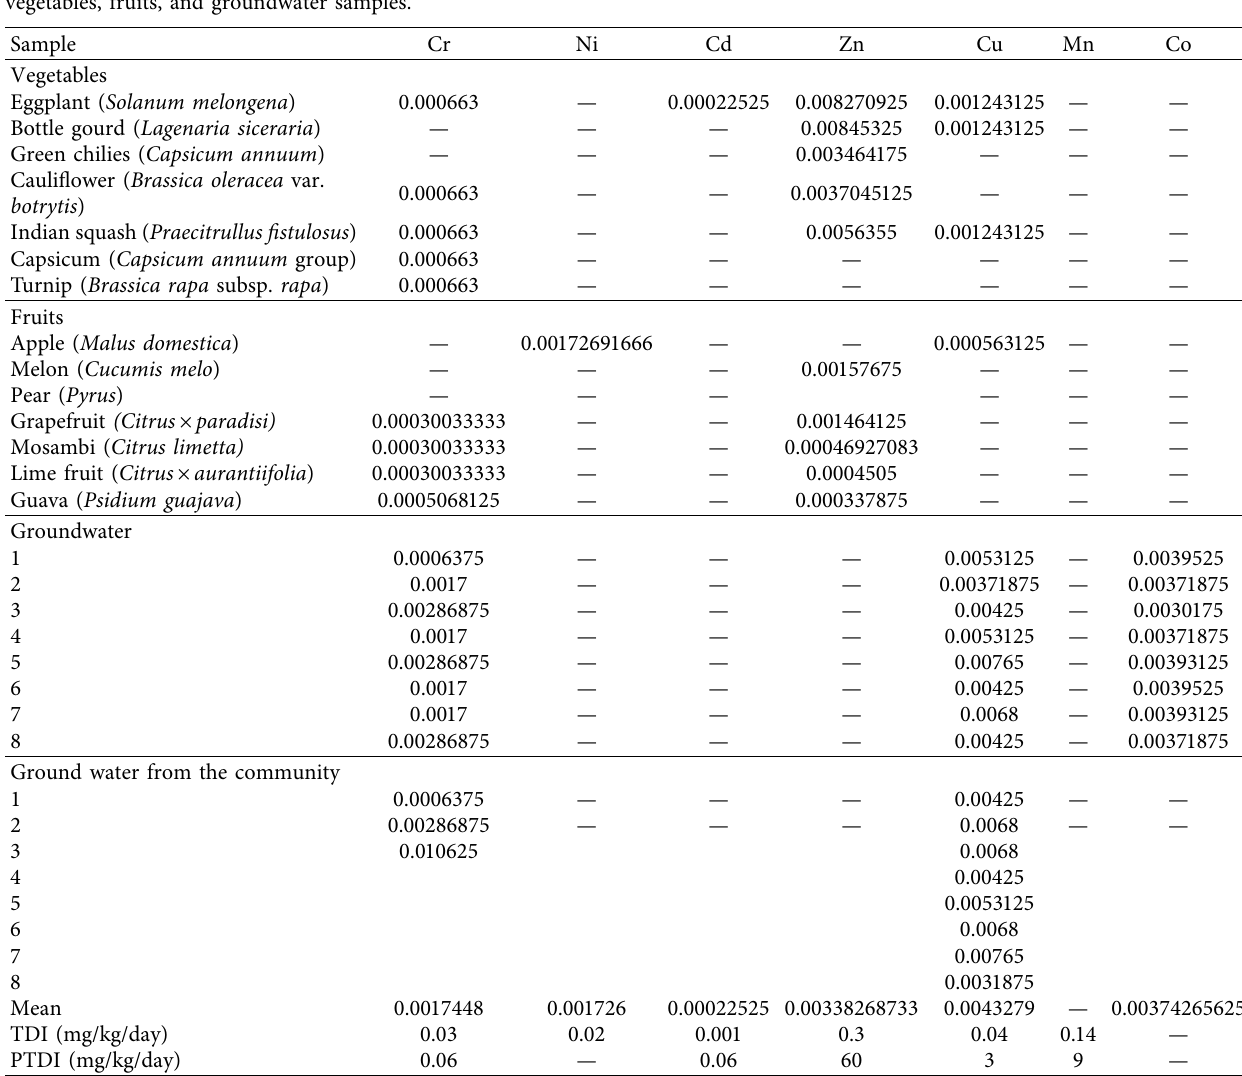
Table 3: Comparison of daily intake of metal with tolerable daily intake (mg/kg/day) and provisional tolerable daily intake (mg/kg/day) for vegetables, fruits, and groundwater